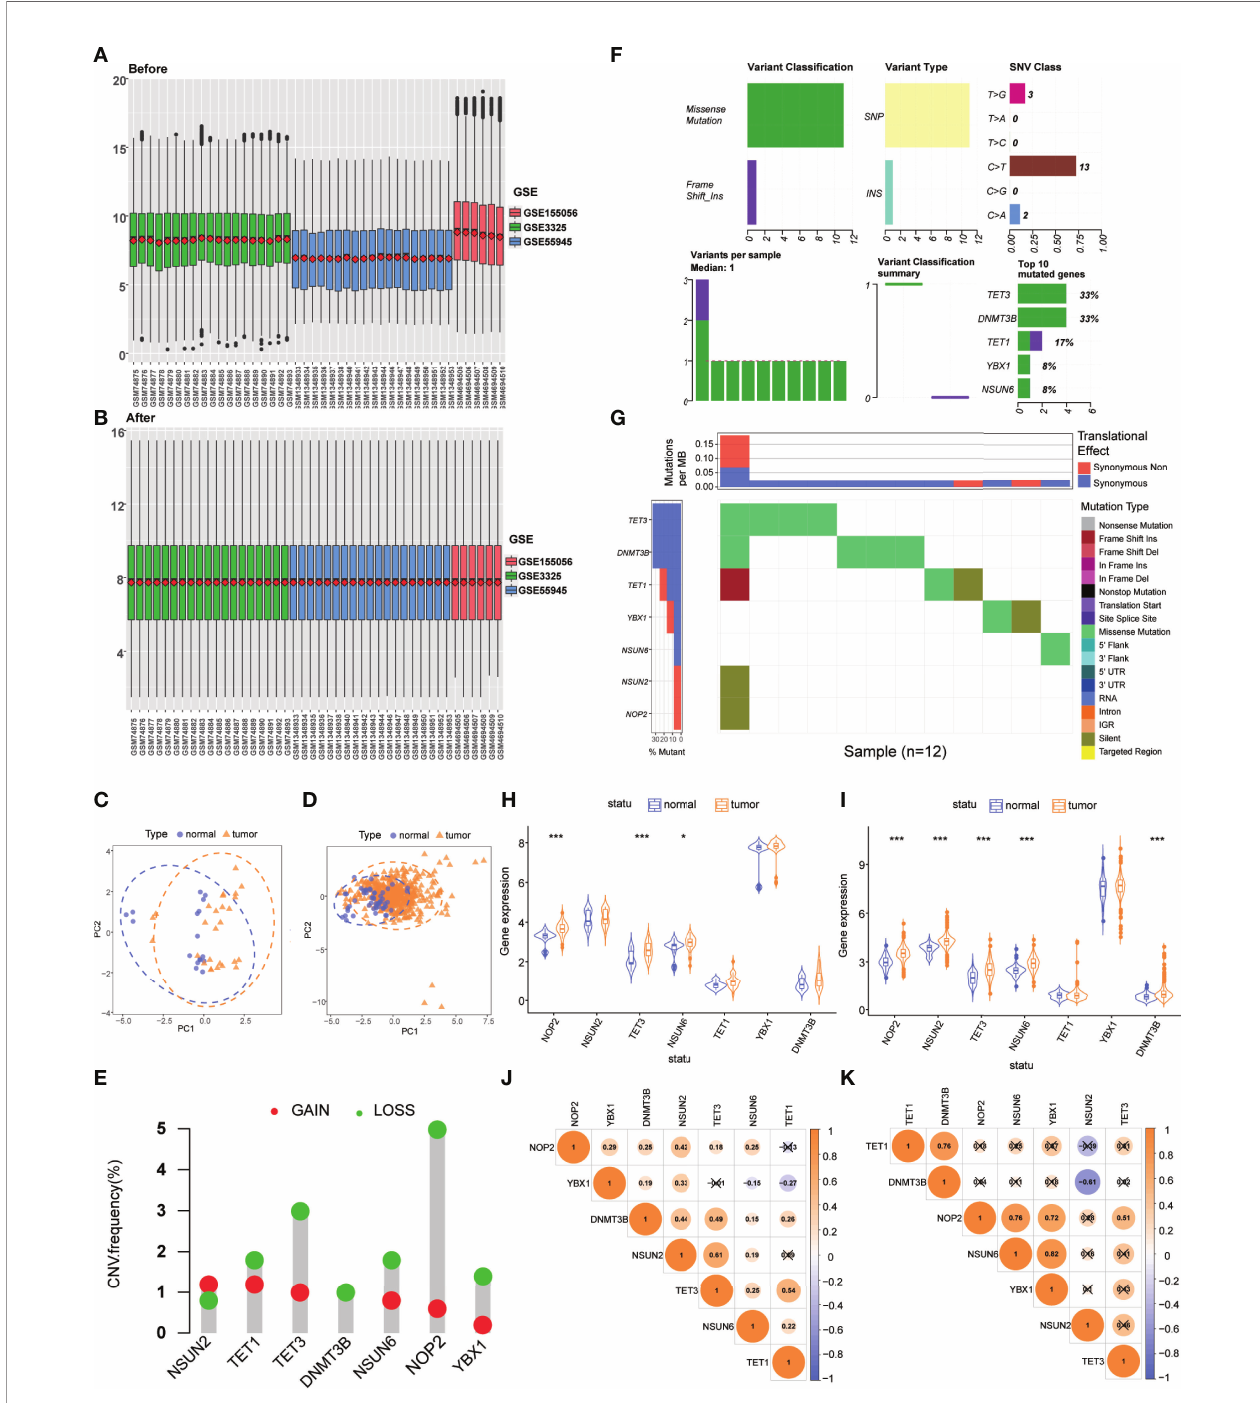
FIGURE 1 | Genetic and transcriptional alterations of m5C regulatory genes in PCa. (A) Gene expression levels of three GEO datasets before integration. (B) Gene expression levels of three GEO datasets after integration. (C) PCA for the expression pro fi les of m5C regulatory genes to distinguish tumors from normal samples in the integrated GEO dataset (normal, blue; tumor, orange). (D) PCA for the expression pro fi les of m5C regulatory genes to distinguish tumors from normal samples in the TCGA dataset (normal, blue; tumor, orange). (E) CNV ampli fi cations and deletions of m5C regulatory genes. (F) The landscape of genetic variation of m5C regulatory genes. (G) SNV categories and frequencies of m5C regulatory genes. (H) The expression of 7 m5C regulatory genes between tumor and normal samples in the integrated GEO dataset. (I) The expression of 7 m5C regulatory genes between tumor and normal samples in the TCGA dataset. (J) Co-expression analysis of m5C regulatory genes in the integrated GEO dataset. (K) Co-expression analysis of m5C regulatory genes in the TCGA dataset. P - values were shown as * P < 0.05 and *** P <